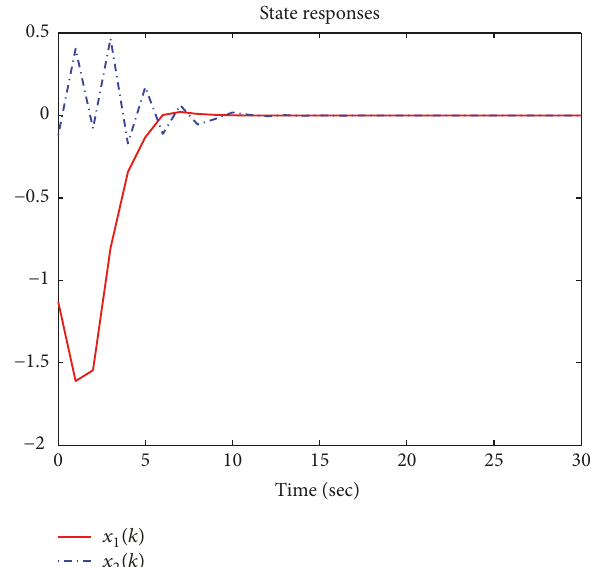
Figure 1: State trajectories of the closed-loop system in Example